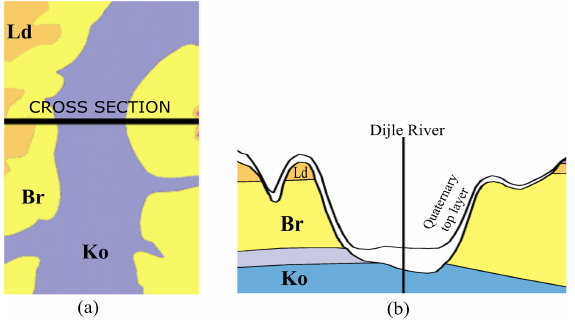
Figure 2. (a) Hydrogeology of Dijle valley around Doode Bemde nature reserve showing the formations of Brussel (Ld & Br) and Ko- rtrijk (Ko). (b) A cross section of the shallow hydrogeology (source: Databank Ondergrond Vlaanderen).